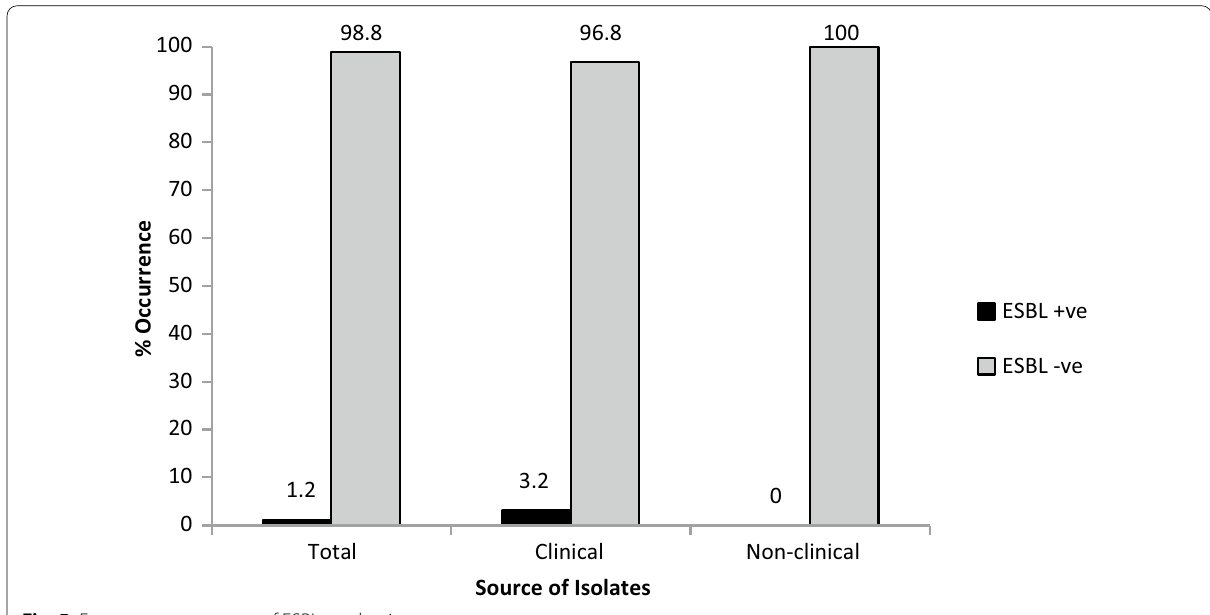
Fig. 5 Frequency occurrence of ESBL